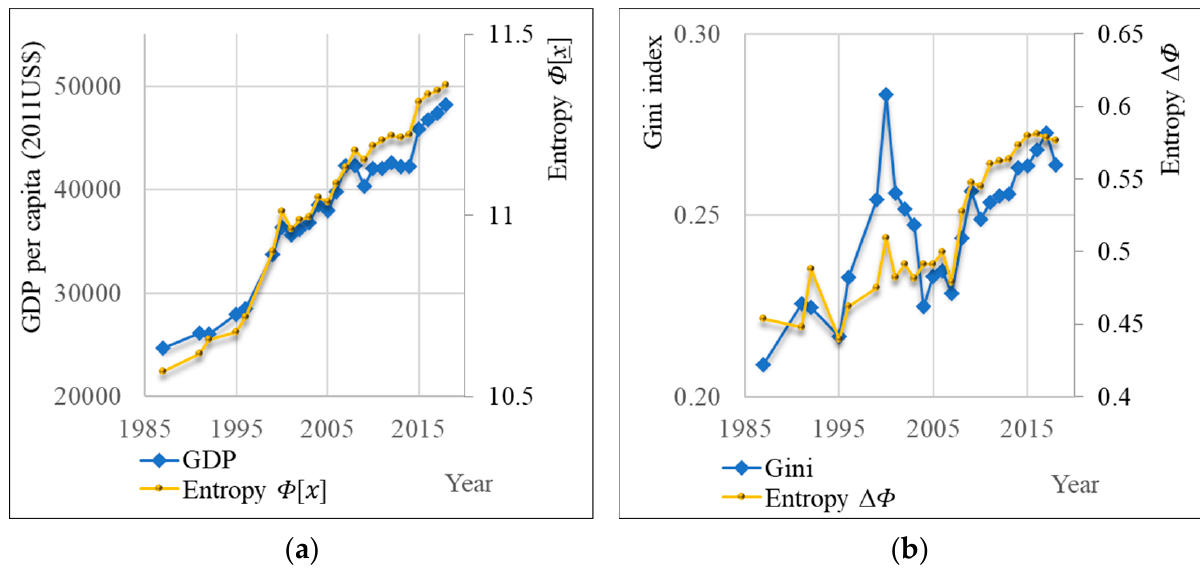
Figure 16. Sweden (1970–2018): ( a ) GDP per capita and Φ [ x ]; (b) Gini and entropic index of inequality Δ Φ .